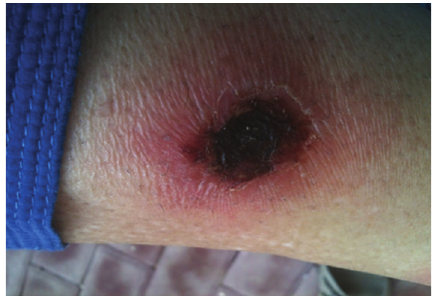
Figure 2: Ultrasound upper abdomen. Multiple hypoechoic tiny lesions on both lobes, few of them cystic in appearance.